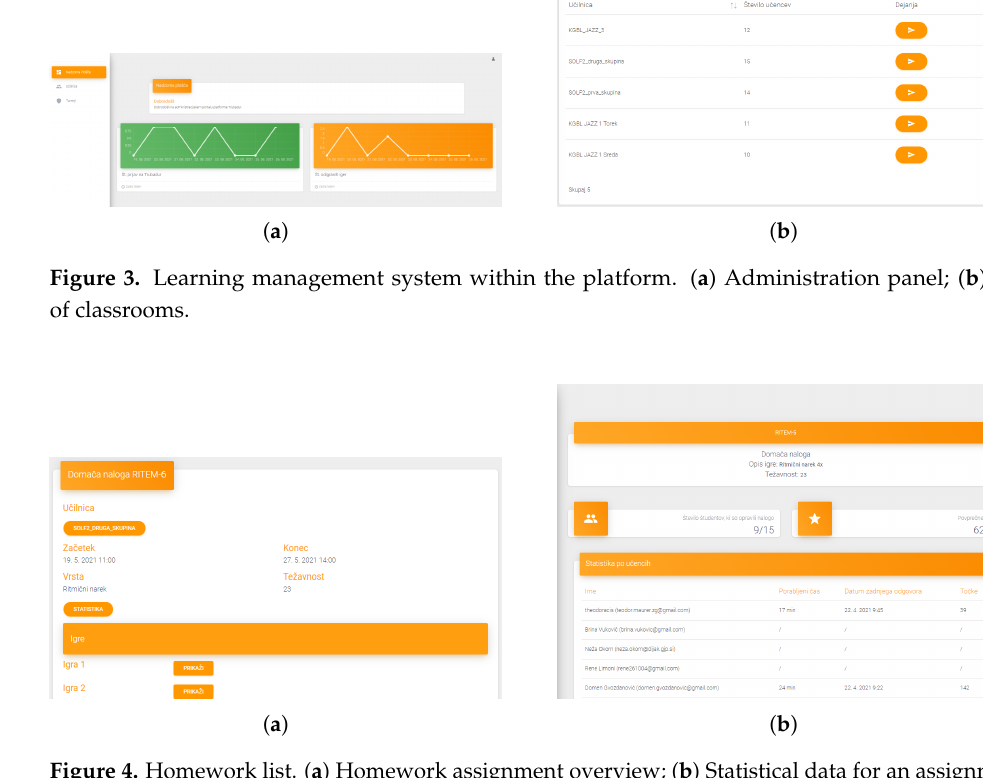
Figure 4. Homework list. ( a ) Homework assignment overview; ( b ) Statistical data for an